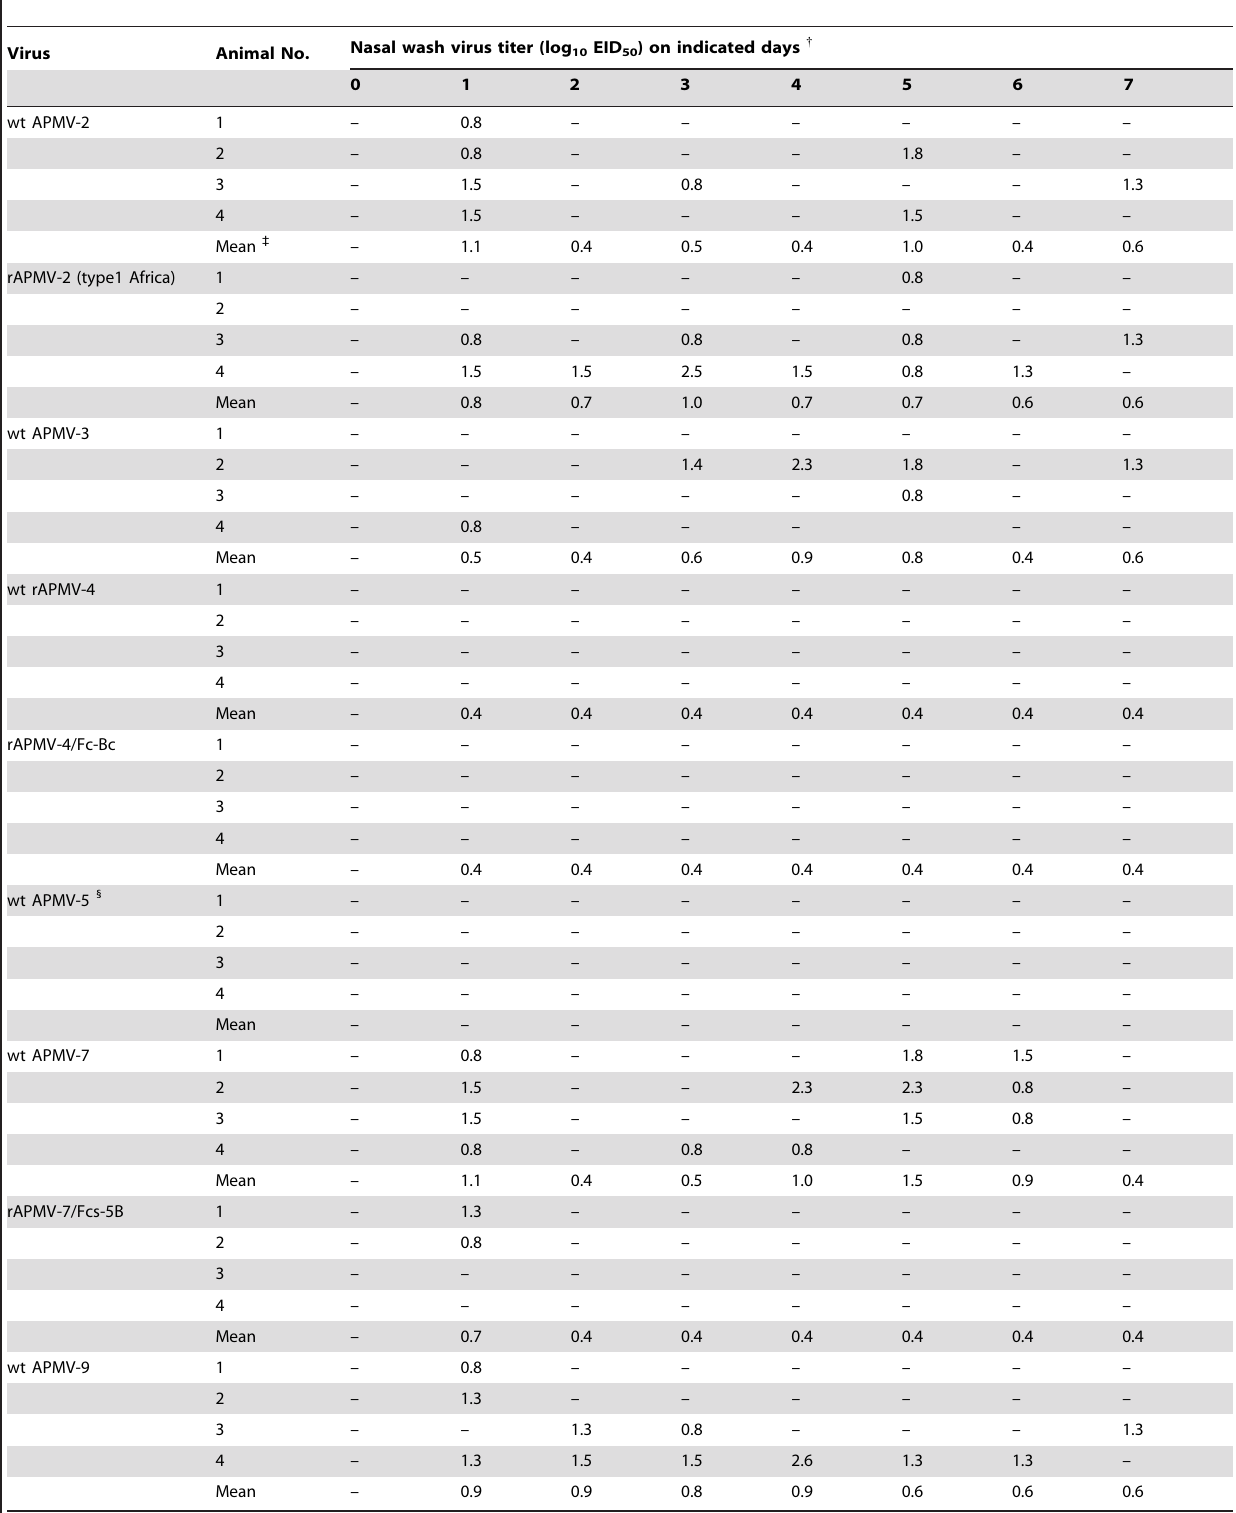
Table 2. Shedding of the indicated APMV strains from the upper respiratory tract of rhesus macaques. *